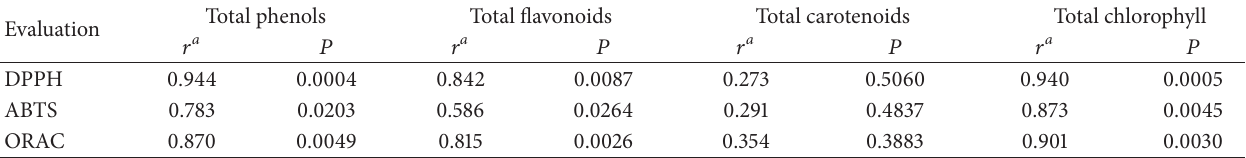
Table 3: Pearson correlation coefficients ( 𝑟 ) and level ( 𝑃 ) of linear regression among different antioxidants and metabolites.